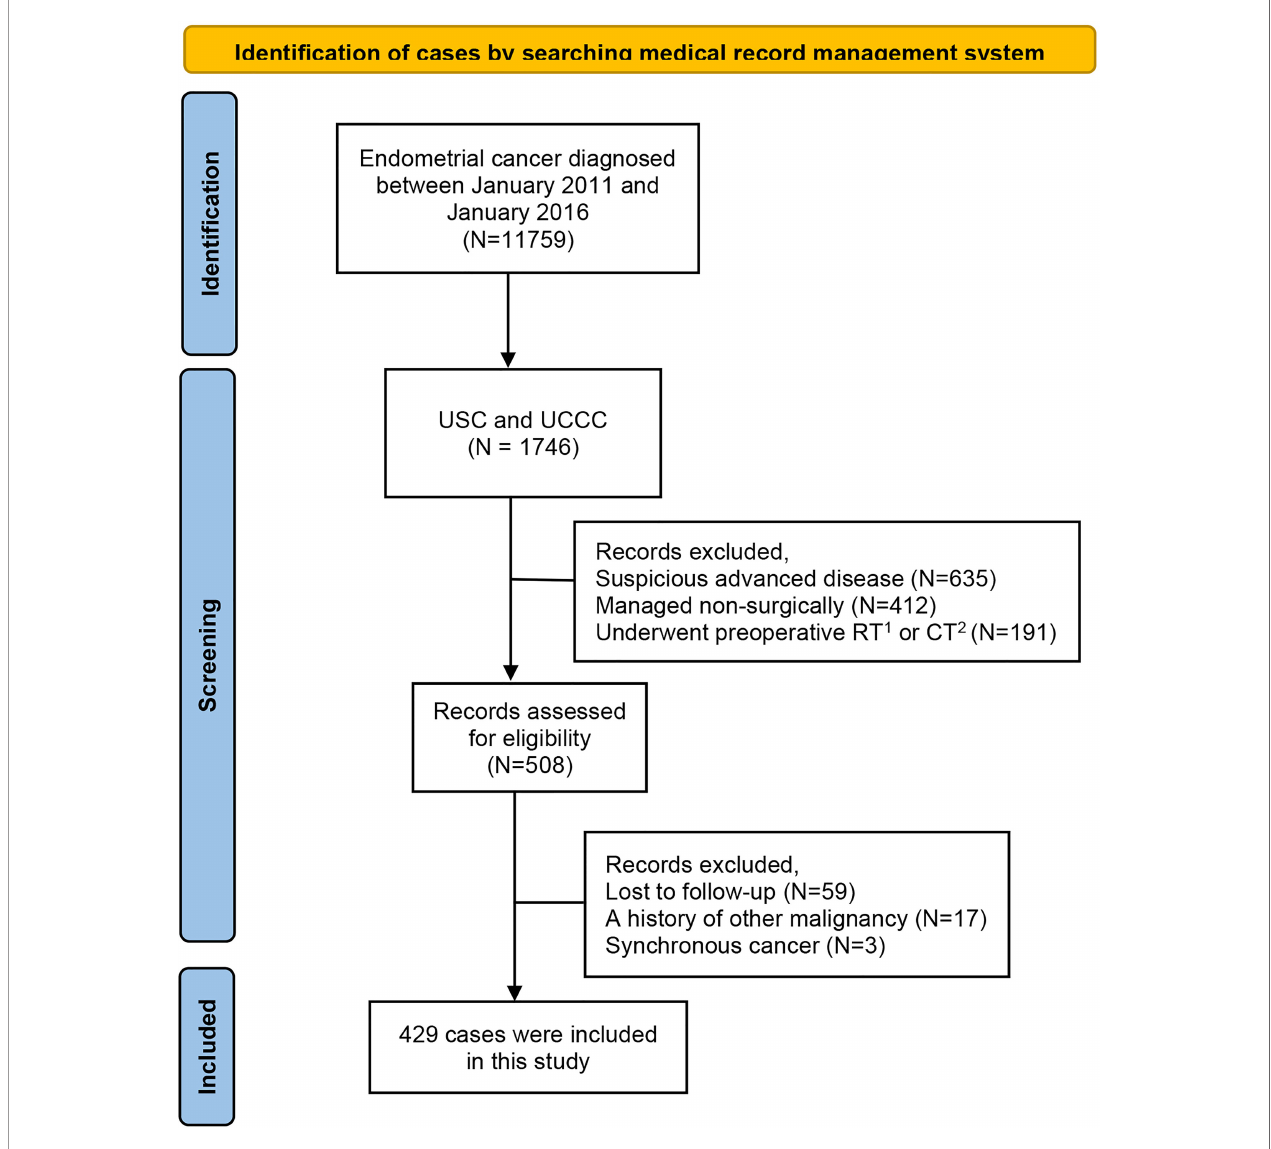
FIGURE 1 | Flow chart of cases